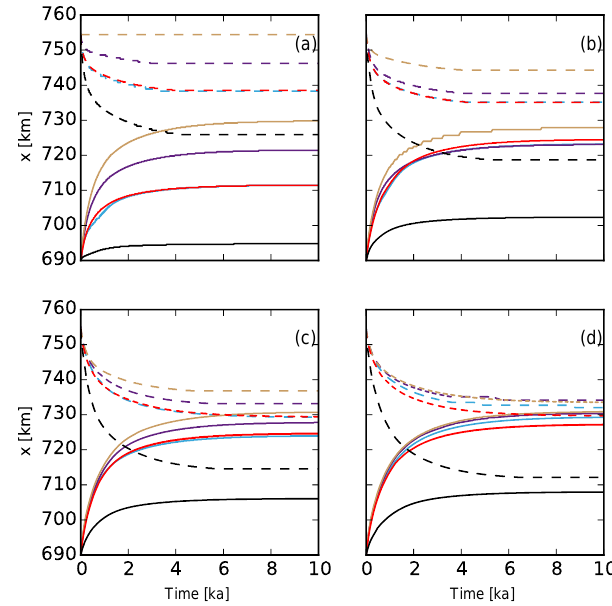
Figure 1. Experiment MISMIP 3a, steps 1 to 4 (advance, solid line) and 5 to 4 (retreat, dashed line): evolution with time of the GL posi- tion for L = 0m and the three GL implementations LG (brown), DI (purple) and FF (blue), L = 60m (red) and L = 500m (black), for the four resolutions (a) 200m, (b) 100m, (c) 50m and (d) 25m.